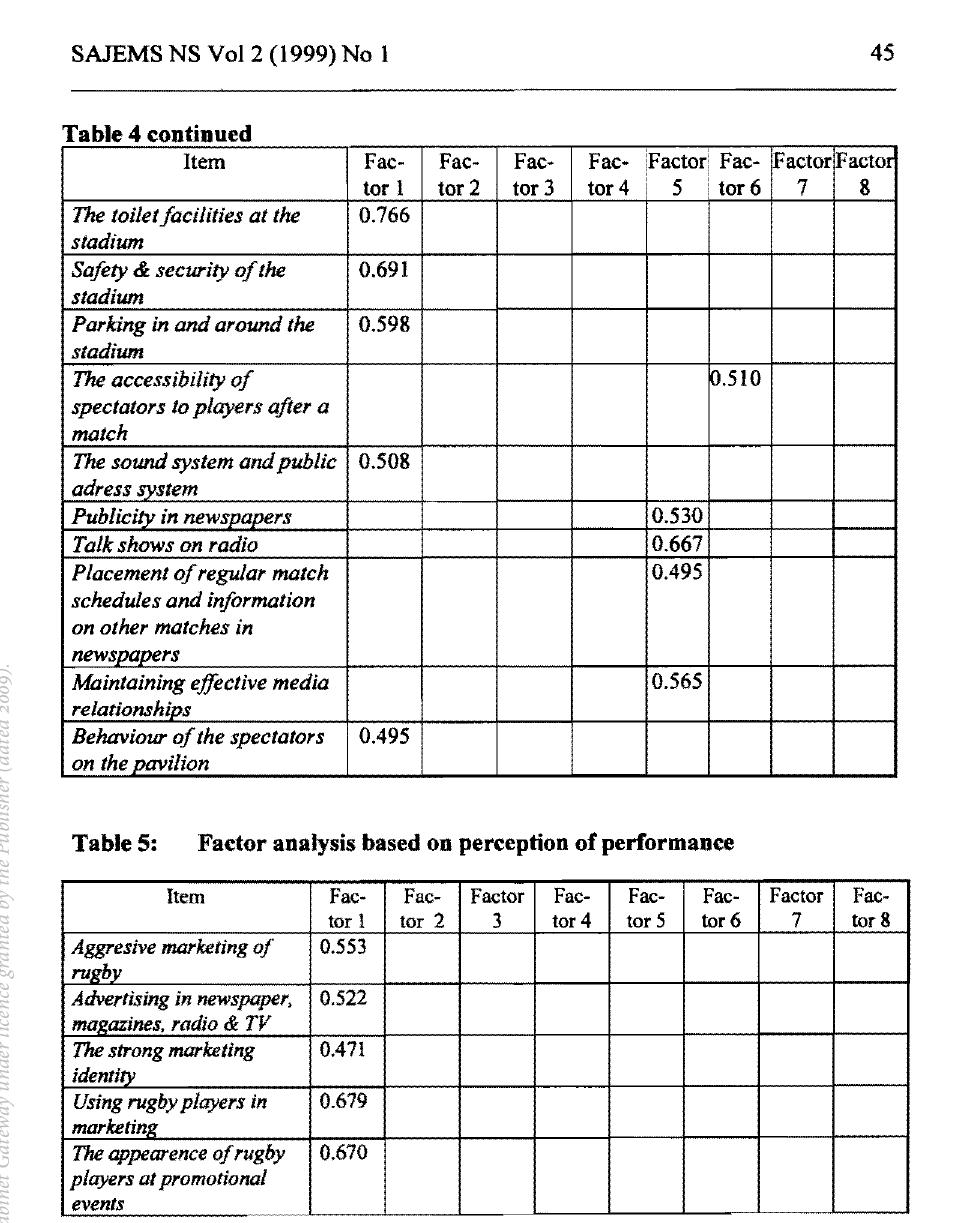
Factor analysis based on perception of